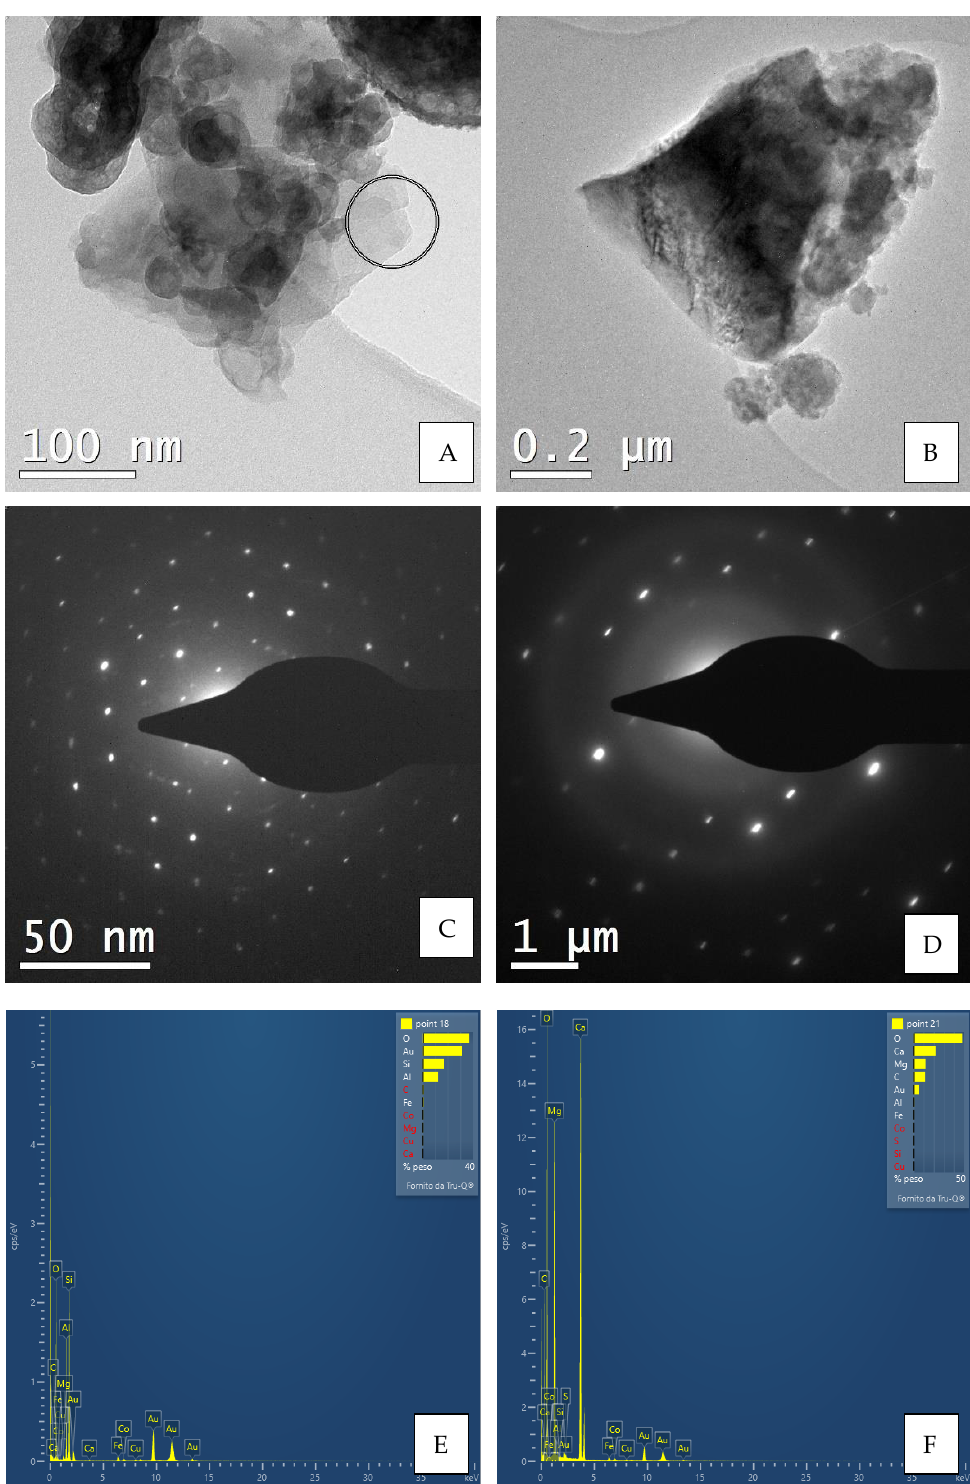
Figure 8. Precipitated phases from FA3-S sample, analyzed by TEM. Two nanocrystal, as the the diffraction patterns reveal: on the left column ( A , C , E ), eudral nanocrystals of Ca-sulfate; on the right side ( B , D , F ), probably a Fe-sulfate nanocrystal covered by aggregates of the amorphous phase.